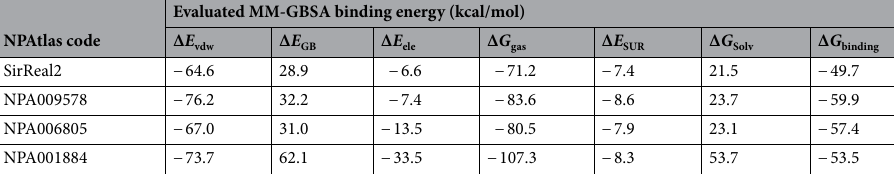
Table 3. Physical parts of the estimated binding energies for NPA009578-, NPA006805-, NPA001884-, and SirReal2-SIRT2 complexes as specified via MD simulation over 200 ns.